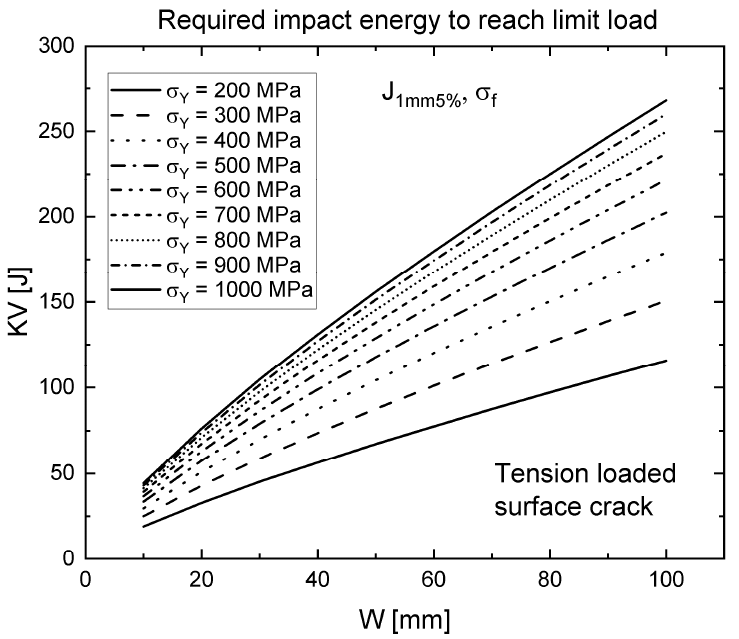
Figure 18. Comparison of angular dependence of elastic–plastic Q parameter normalized by relative stress and elastic T-stress for shallow uniaxial and biaxial tensile-loaded surface flaws [5,13,14].